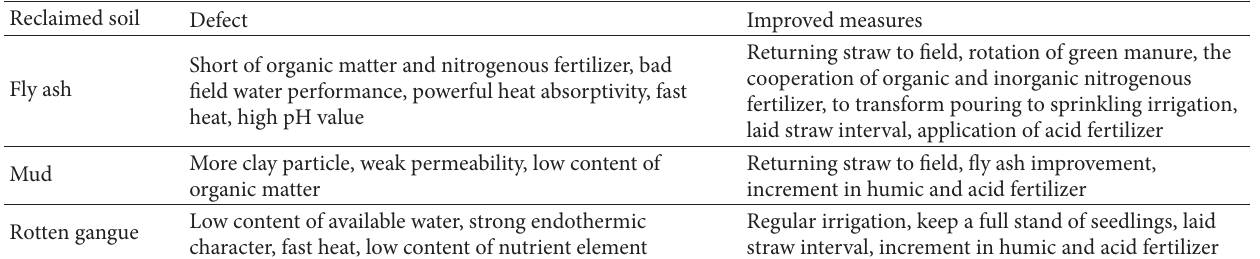
Table 2: The improvement measures for three typical reclaimed